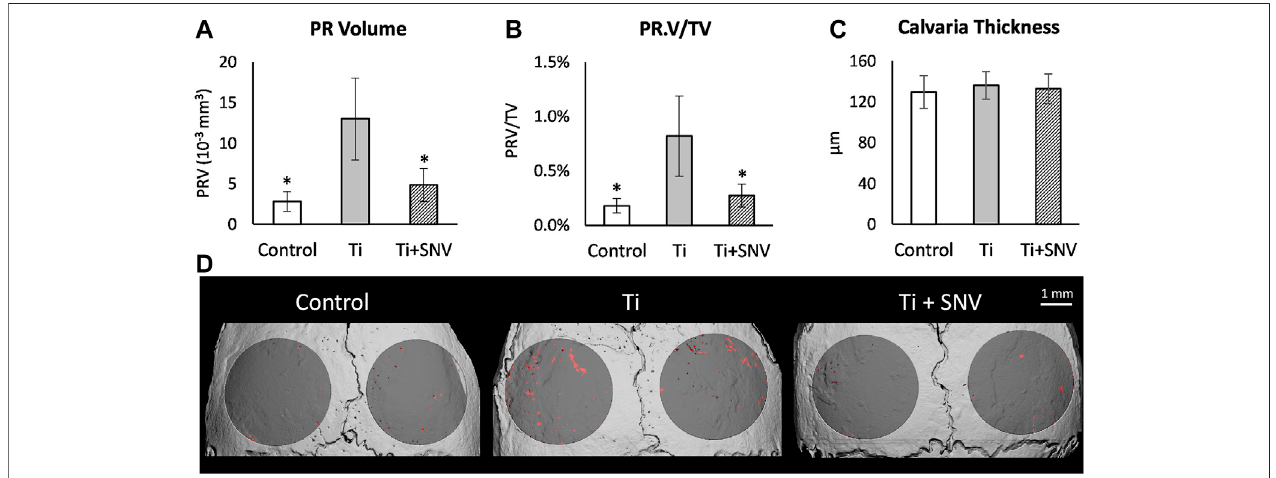
FIGURE 6 | Effect of topically-administered SNV on particle-induced osteolysis in vivo . Fibrin membranes including titanium particles, together with SNV (or saline as control) were implanted onto mouse calvaria. Mice were euthanized 5 weeks post-op for μ CT analysis. (A) Pit resorption volume (PRV, mm 3 ), (B) PRV/TV (%), (C) Calvarial thickness ( μ m). Data are expressed as mean ± SD, n (cid:2) 6-9, * p < 0.05 vs. Ti, ANOVA. (D) Representative μ CT images of the calvaria. The region of interest (ROI) is represented in dark gray, and the resorption pits are denoted in red. Bar (cid:2) 1